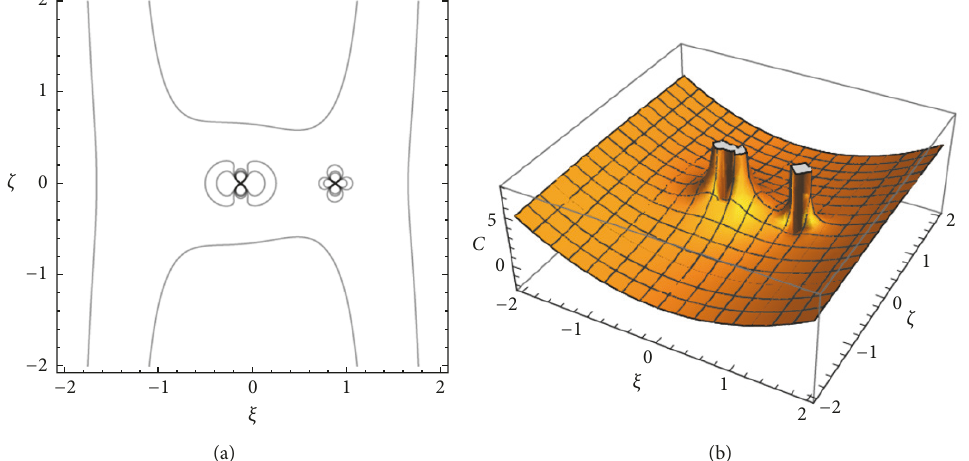
Figure 10: Zero-velocity curves in the ( 𝜉 − 𝜁 ) plane of DP-Leonis for 𝐴 = 0.02, 𝑒 = 0.5,𝑎 = 0.95, 𝜎 1 = 0.03 and 𝜎 2 = 0.015.